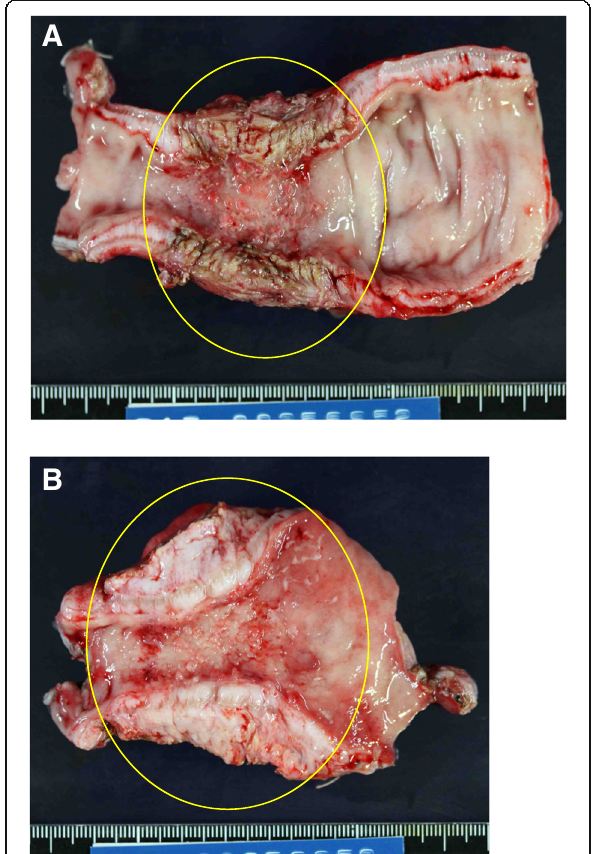
Fig. 5 Images a and b are histological findings of the specimen. A large number of plasma cells and IgG4-positive cells are seen in the specimen. The ratio of IgG4-positive cells to non IgG-positive cells is 87%